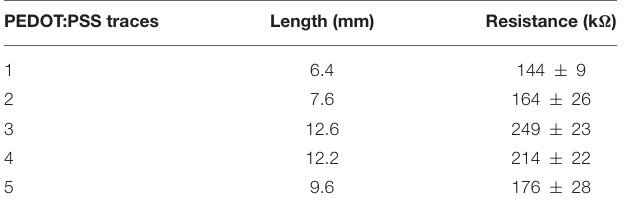
TABLE 1 | Electrical characterization of PEDOT:PSS traces, averaged over 4 samples. PEDOT:PSS traces Length (mm) Resistance (k (cid:127)